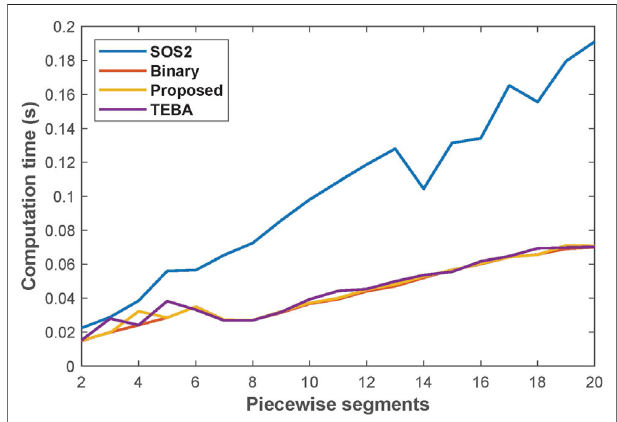
FIGURE 6 | Computation time of four PWL approaches with increasing segments.